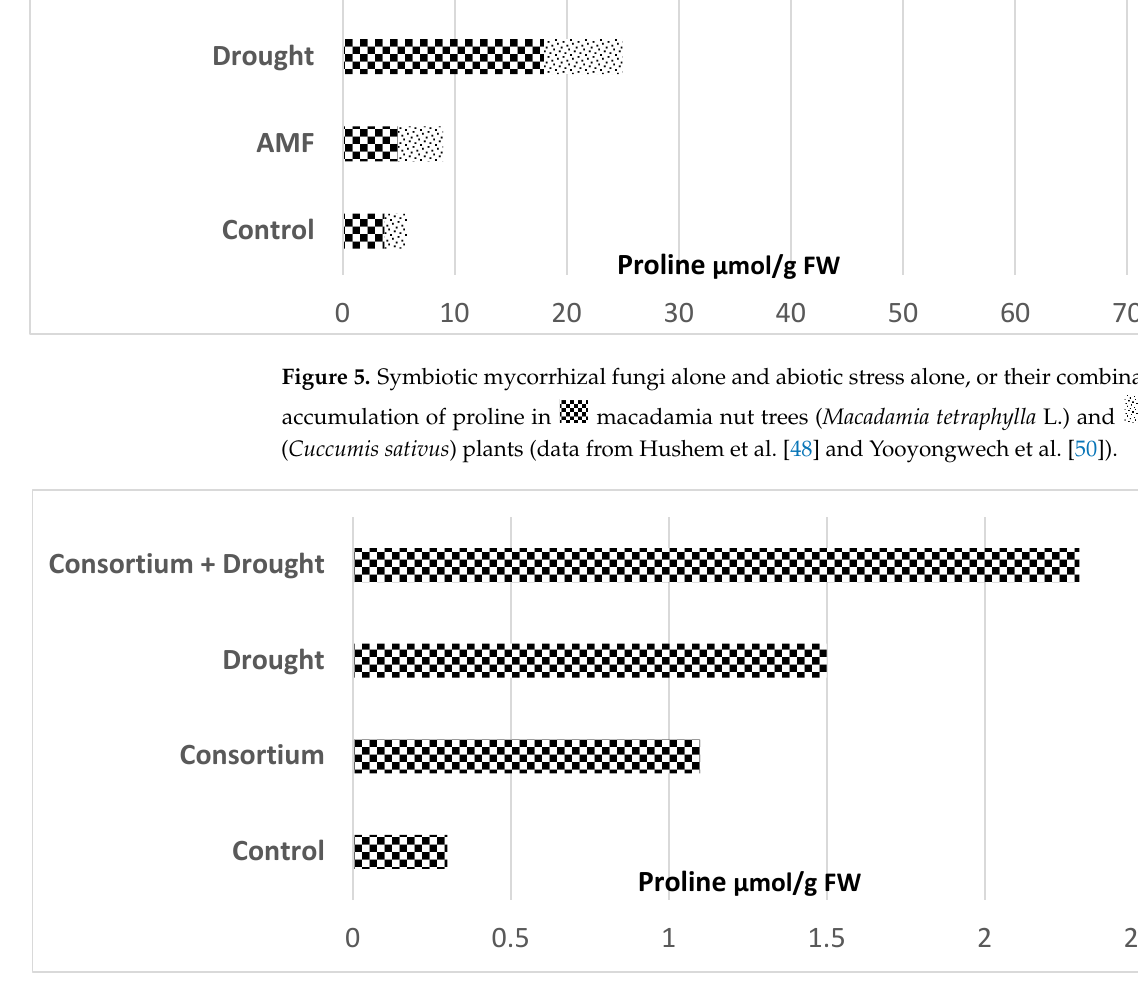
Figure 6. Plant-growth-promoting (PGP) Bacillus bacteria consortium ( B. subtilis, B. megaterium , and B. thuringiensis ) and abiotic stress alone, or their combination, altered average accumulation of proline in two different